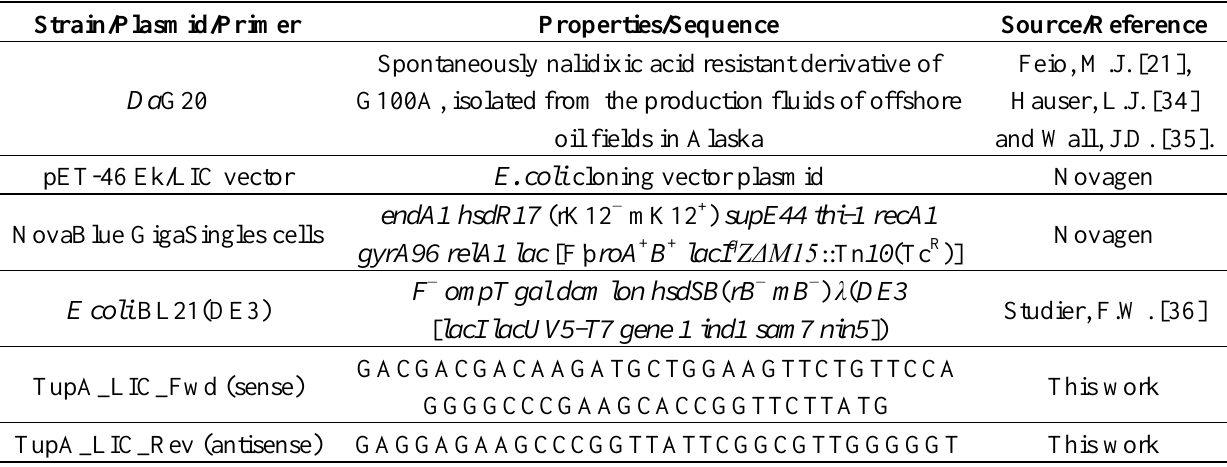
Table 3. Bacterial strains and plasmids used in this